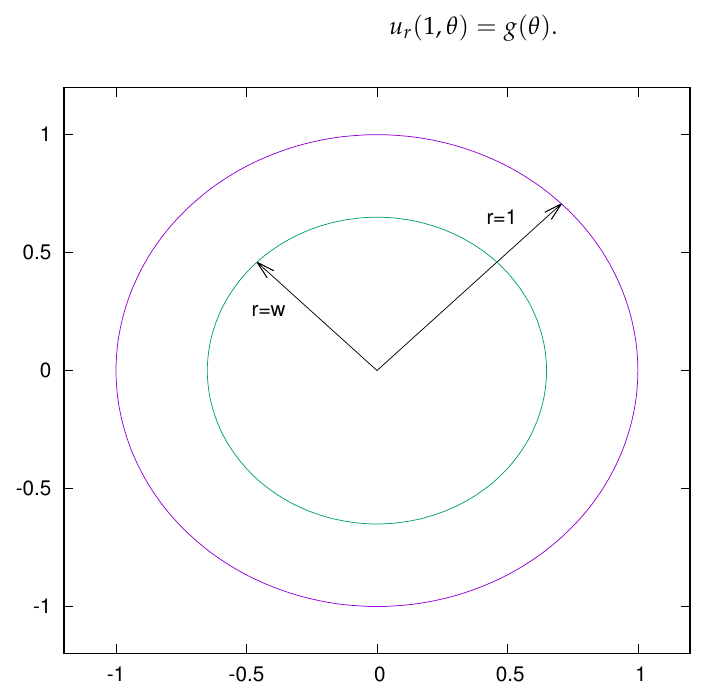
Figure 1. A cross section of a